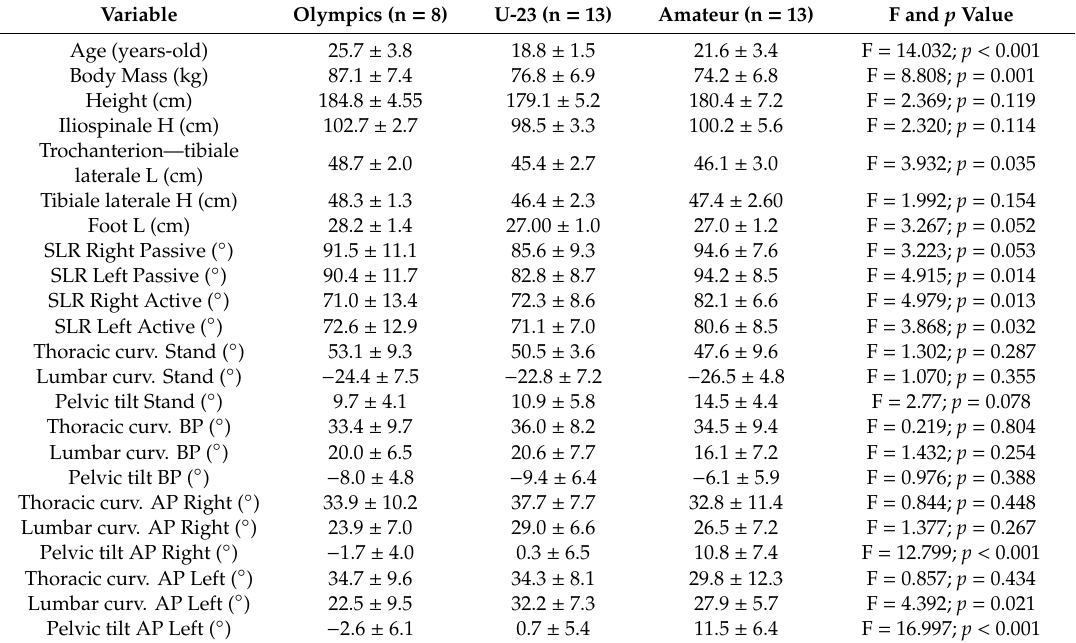
Table 1. Anthropometric characteristics, hamstring extensibility, and sagittal spinal curvatures of the di ff erent groups of kayakers (mean ± standard deviation).